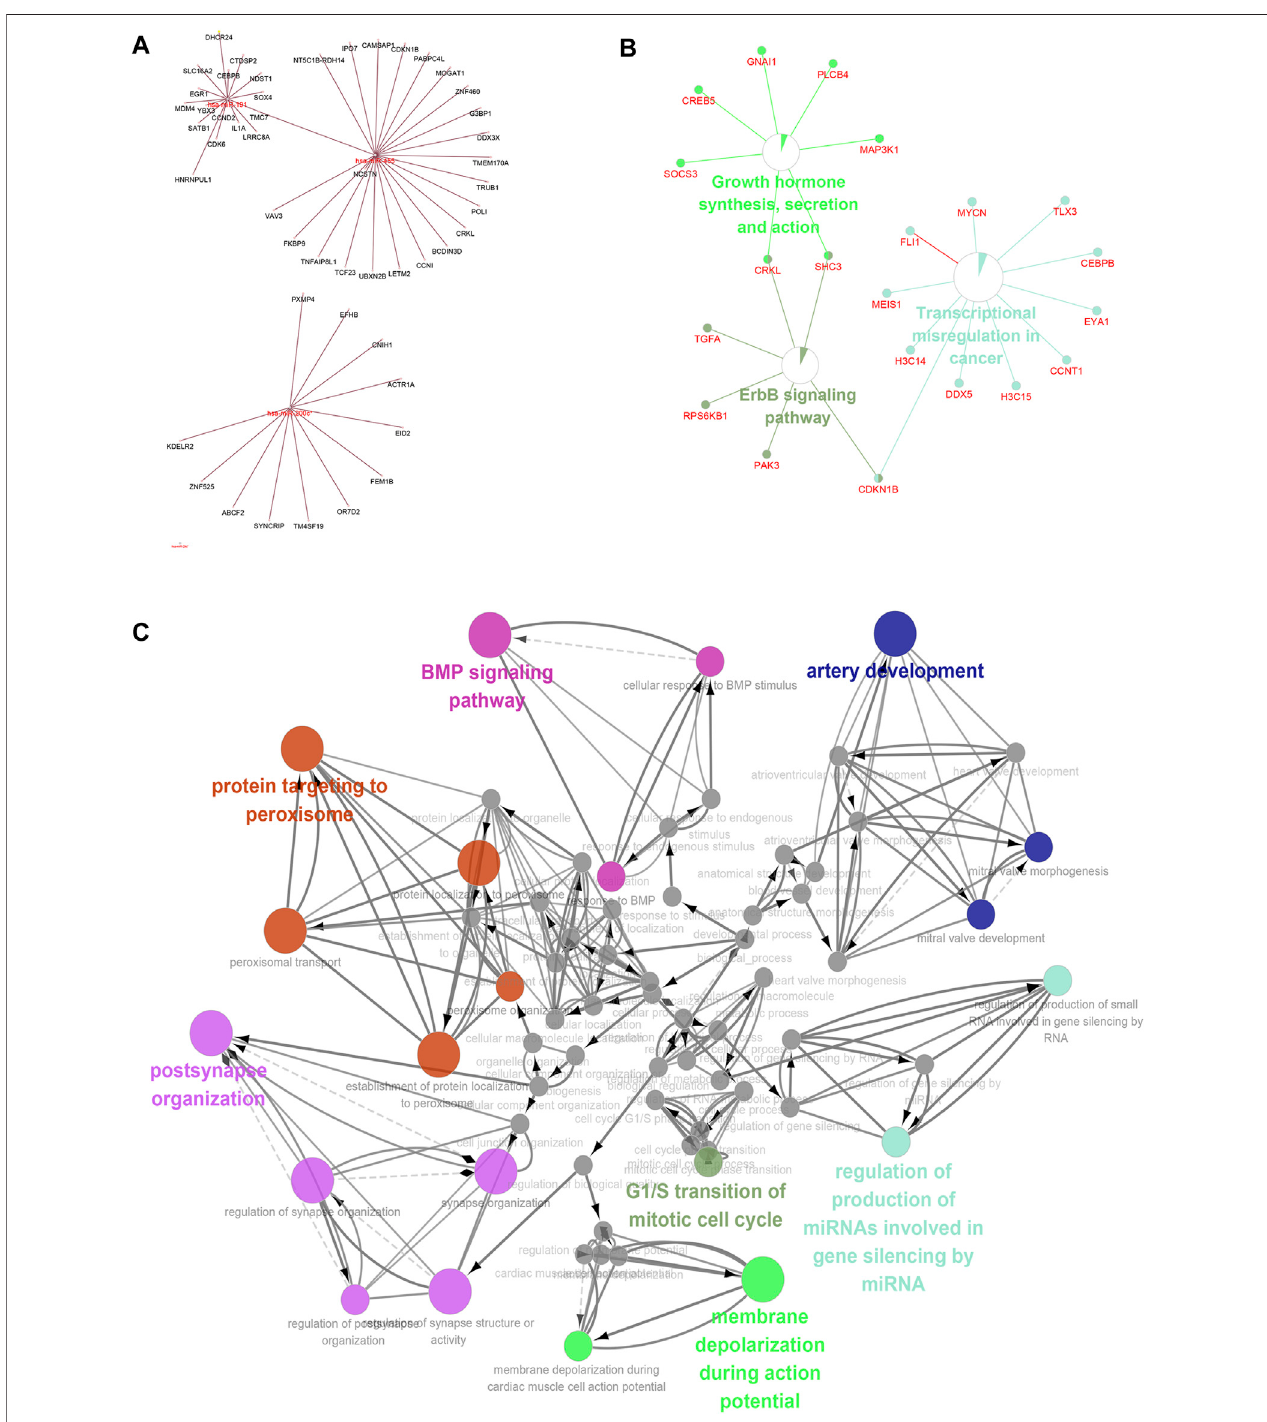
FIGURE 8 | Pathway enrichment analysis of long non-coding RNA-micro RNA (miRNA)-messenger RNA (mRNA)-Kyoto Encyclopedia of Genes and Genomes/ gene ontology pathway. Combining the above predicted mRNA-miRNA prediction results, the miRNAs and mRNAs with key predicted interactions were enriched for miRNA and mRNA functions using ClueGO and Cluepedia ( Figures 8A – C